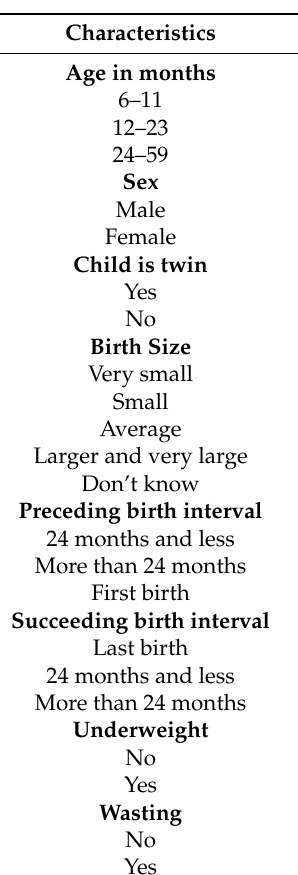
Table 2. Characteristics of under-5 children in Nepal, n =